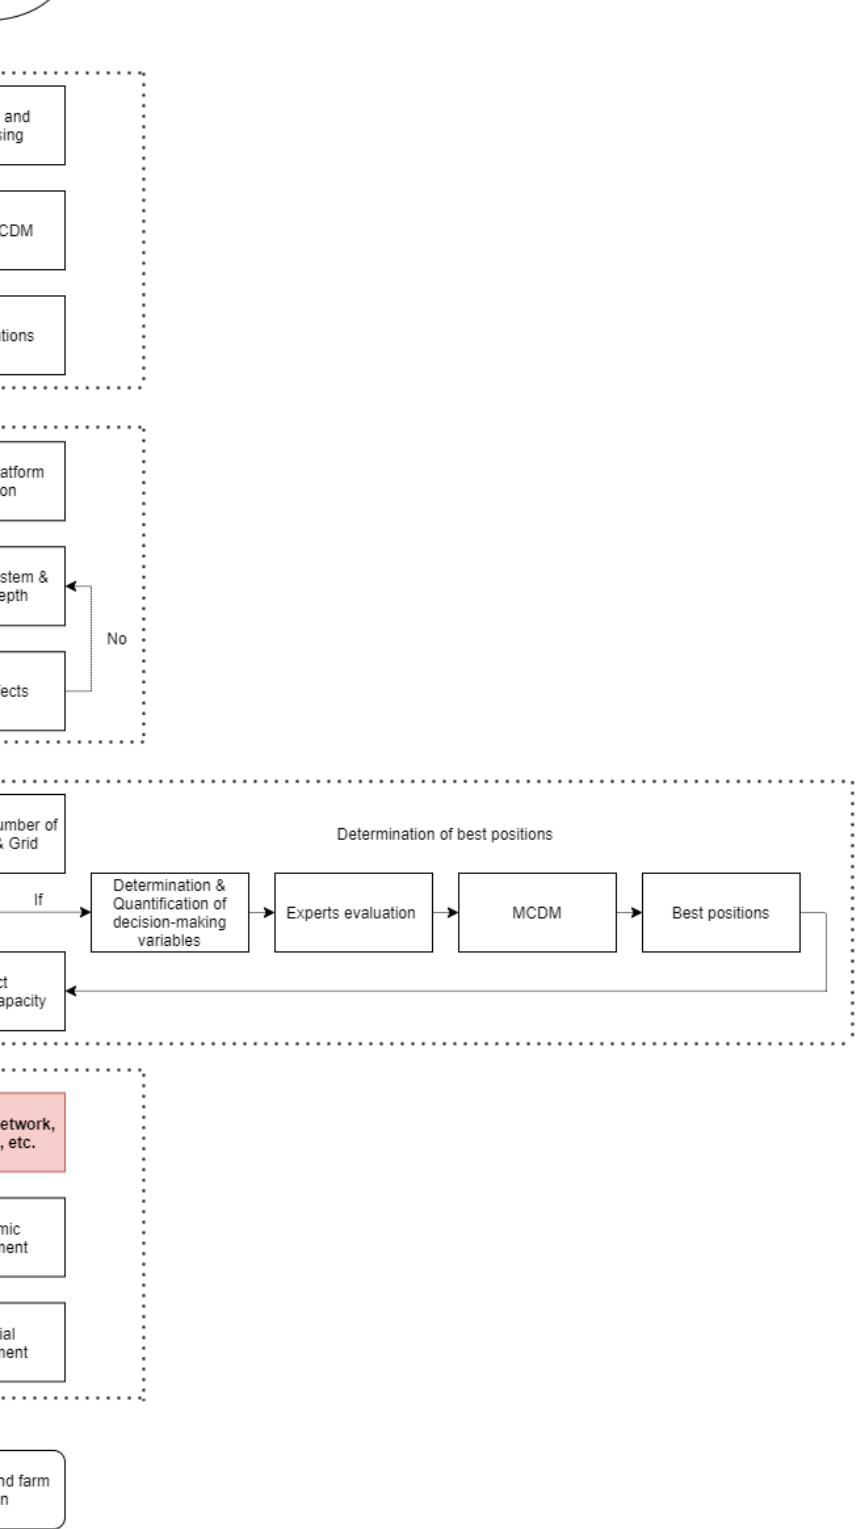
Figure 1. Floating wind farms design flowchart. The red colour block represents the step presented in this paper.